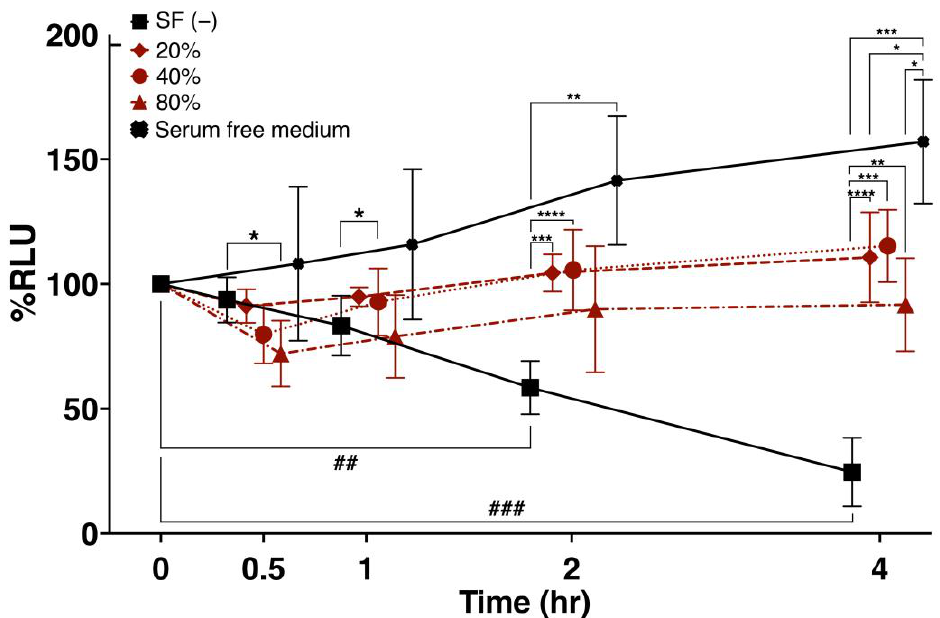
Figure 2. Viability of cultured ADSCs in response to SF. The percent change in ADSC viability following treatment with 0%, 20%, 40%, and 80% SF for various times was evaluated for six SF samples representing Knee OA. SF (−) refers to ADSCs suspended in 100 μL of saline. SF (+) refers to ADSCs in saline containing 20%, 40%, and 80% SF. SF samples obtained from six separate Knee OA patients were used. * p < 0.05, ** p < 0.01, *** p < 0.001, **** p < 0.0001, ## p < 0.01 and ### p < 0.001 are shown. Data are expressed as the mean ± S.D.